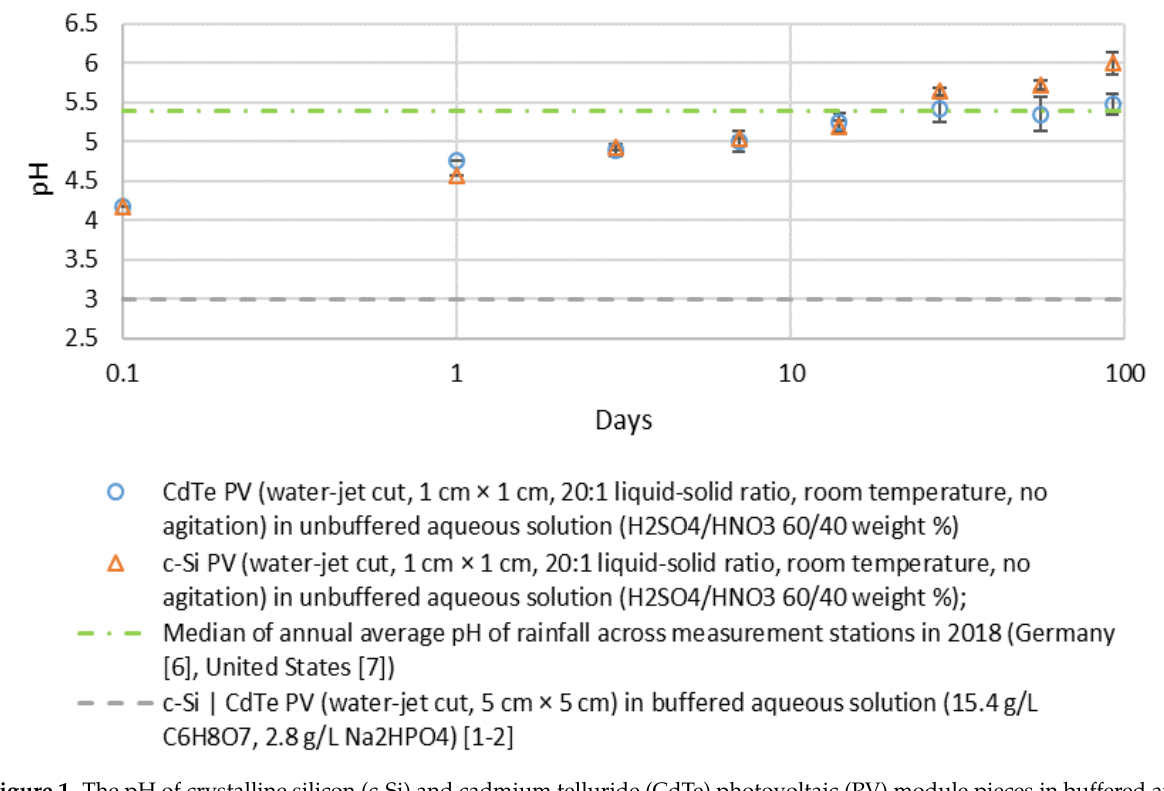
Figure 1. The pH of crystalline silicon (c-Si) and cadmium telluride (CdTe) photovoltaic (PV) module pieces in buffered and unbuffered aqueous solution over time, along with median pH in rainfall in Germany and the U.S. in 2018. (Note-sulfuric acid: H 2 SO 4 , nitric acid: HNO 3 , citric acid: C 6 H 8 O 7 , disodium hydrogen phosphate: Na 2 HPO 4 )